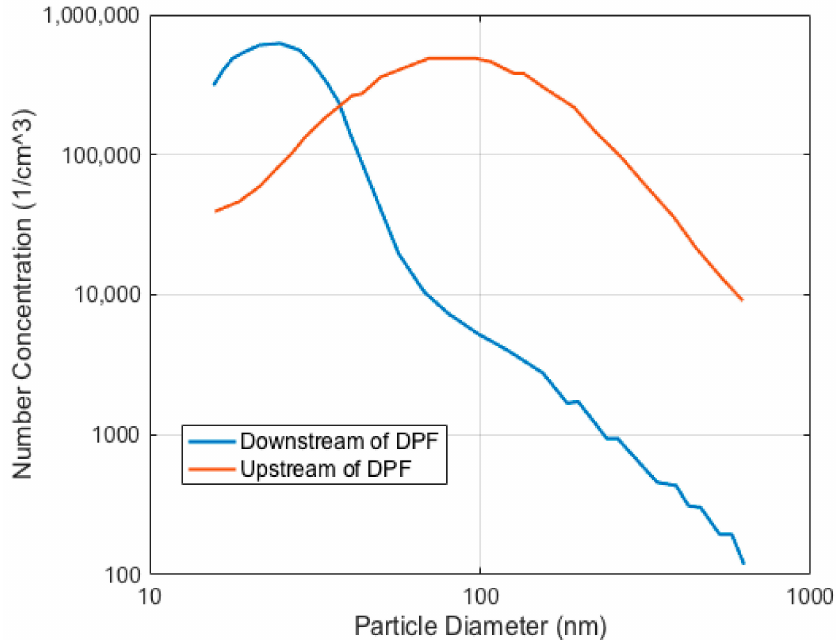
Figure 1. Typical size distribution of the particulate matter downstream and upstream of the Diesel Particulate Filter